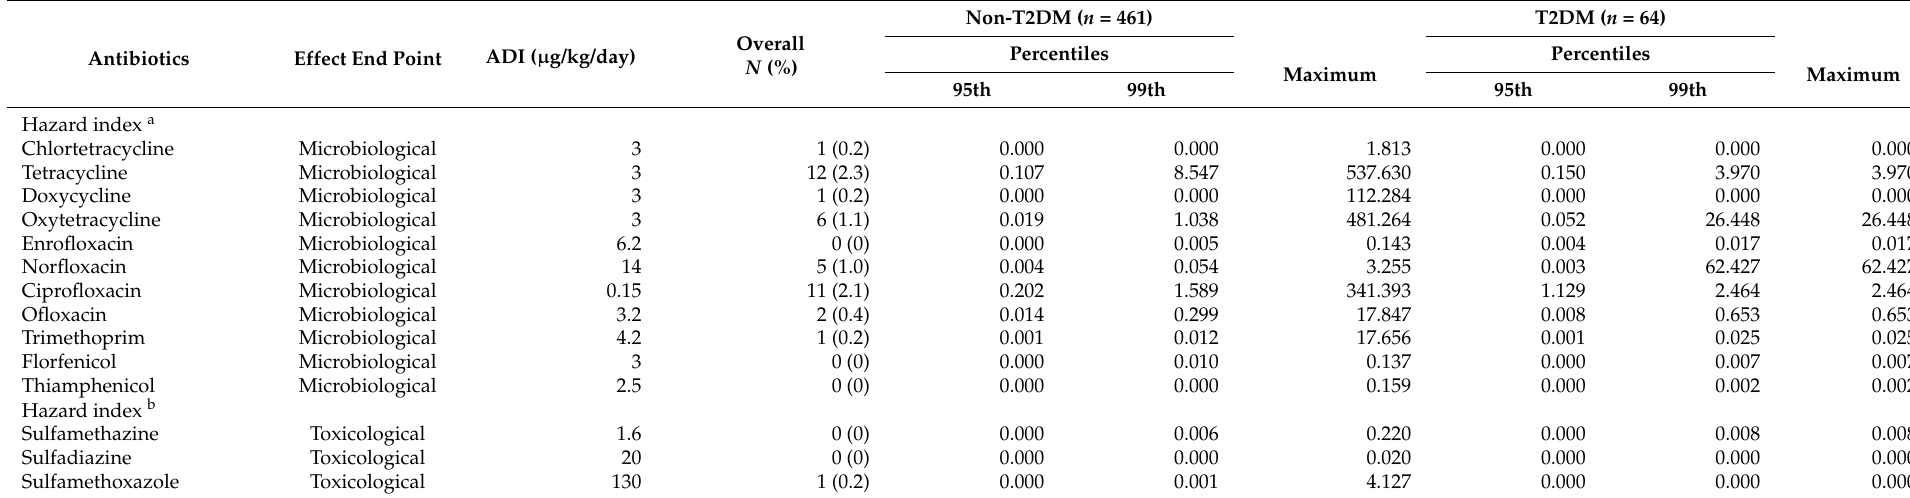
Table 3. Hazard quotient (HQ) of veterinary antibiotics and human/veterinary antibiotics among middle-aged and older people in Xinjiang ( n =